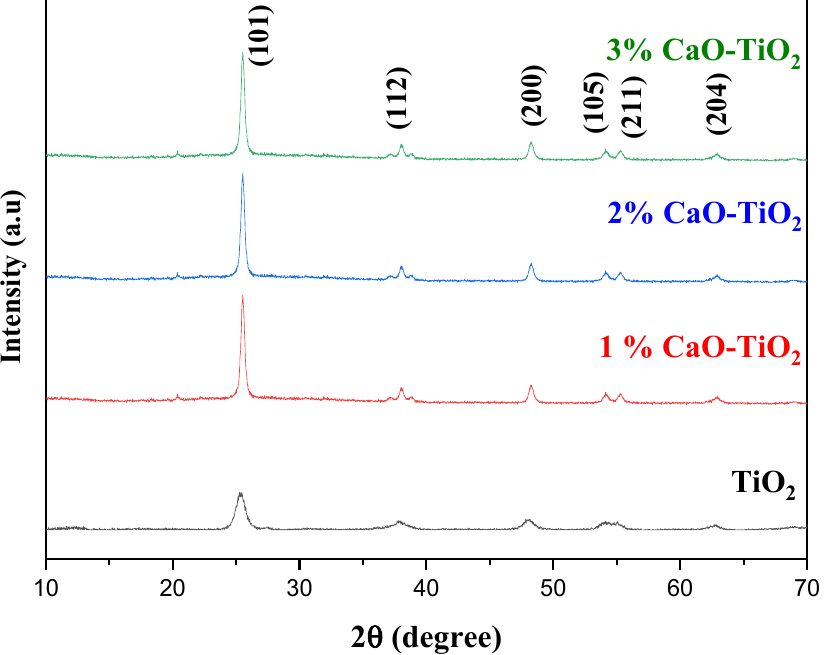
Figure 1. XRD pattern of unloaded TiO 2 and 1–3% CaO loaded TiO 2. The Raman spectrum is further used for the phase and structural identification of pure and impregnated TiO 2 catalysts. As is shown in Figure 2, three characteristic vibra- tional modes of TiO 2 are observed at 395, 512, and 640 cm − 1 with symmetries of B 1g , A 1g /B 1g, and E g , respectively, clearly indicating the existence of anatase phase and no additional peak for rutile or brookite phase is detected [60,61]. Thus, the results are in good agree- ment with XRD results. Moreover, CaO impregnated TiO 2 (1–3%) does not present any peak shifts while intensity and broadness were affected by the concentration and impreg- nation of metal. The peak shifting strongly depends on the number of impurity defects while in (1–3%) CaO impregnated TiO 2 concentration of impurities is low, thus no shifting was observed [62]. Only minor changes were observed in the symmetry of TiO 2 due to lattice distortion generated due to defects with CaO substitution [63], where change in intensities supports CaO loading. All the peaks of CaO loaded TiO 2 samples show a sig- nificant increase in intensities with an increase in the concentration of CaO loading that support the results obtained in XRD patterns.